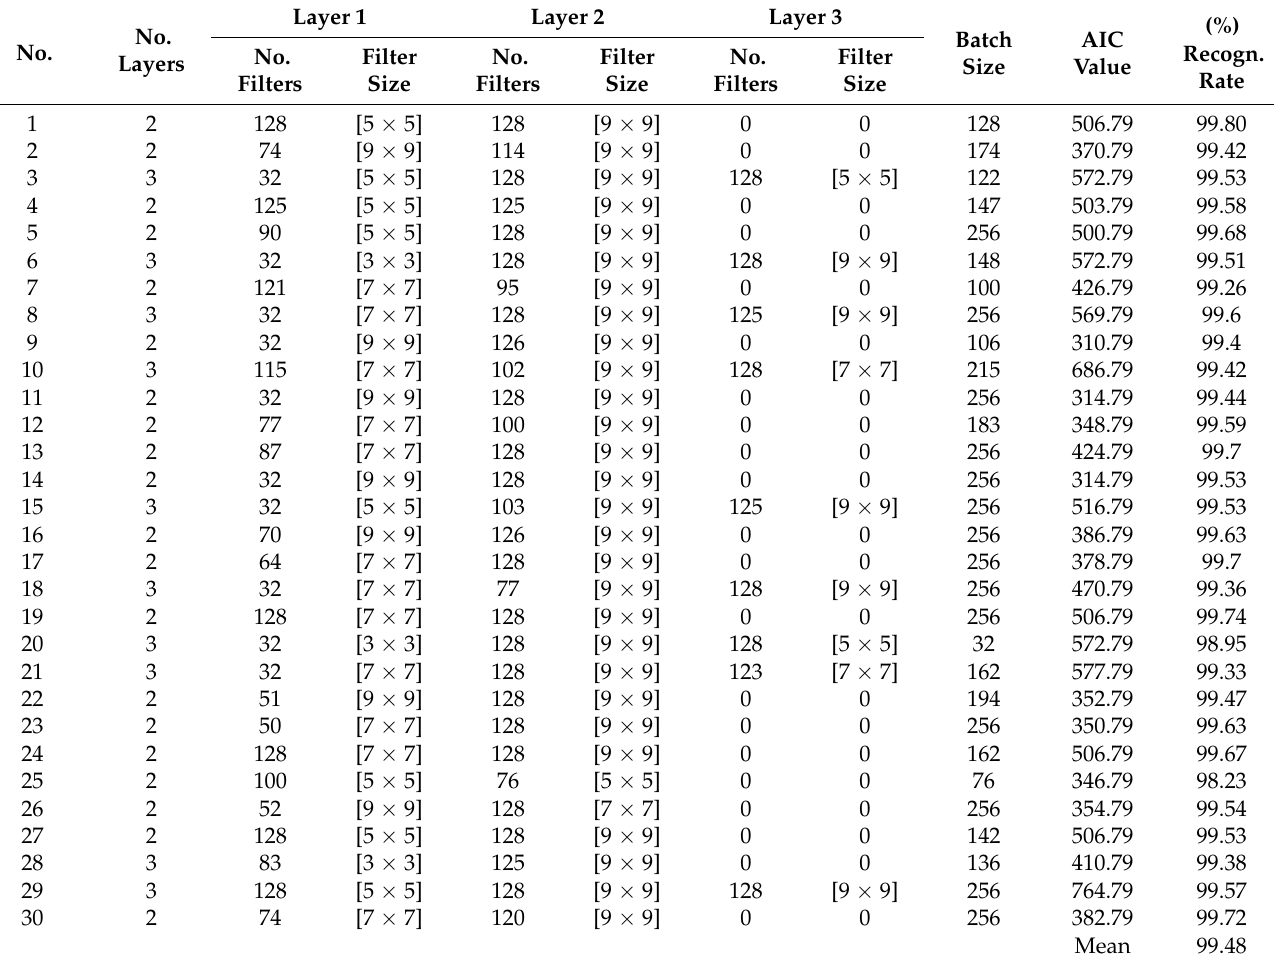
Table 13. Results achieved by the PSO-CNN-II in ASL MNIST